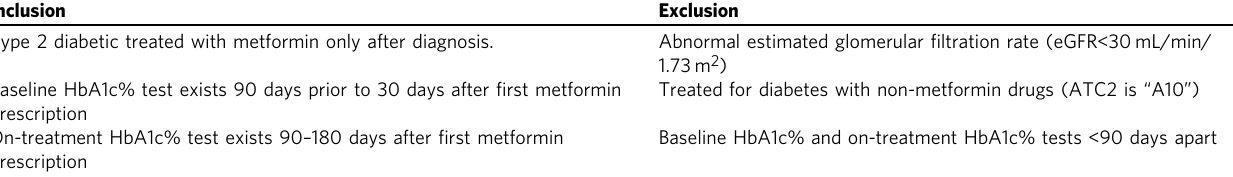
Table 1 Inclusion exclusion criteria. Inclusion Exclusion Type 2 diabetic treated with metformin only after